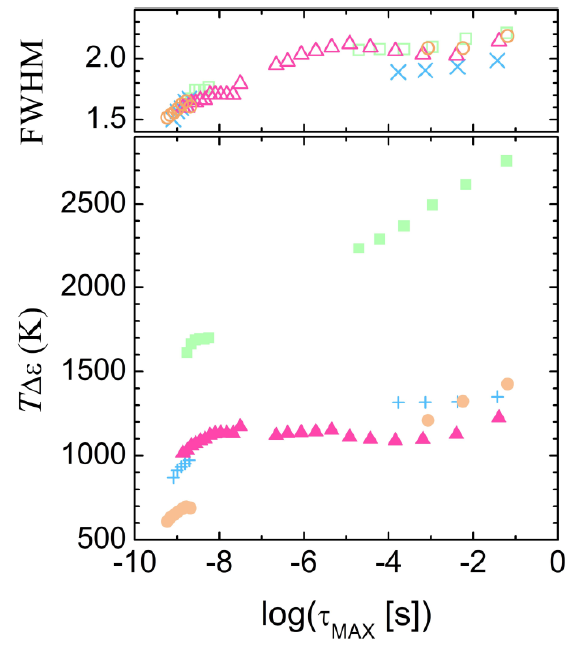
Figure 5. Relaxation strength ( 𝑇∆𝜀 ) and FWHM as a function of the relaxation time ( 𝜏 MAX ). Solid symbols correspond to: ■ PTF, + PBF, ▲ PPeF, ● PHF. Empty symbols show the FWHM data: □ PTF, × PBF, Δ PPeF, ○ PHF.